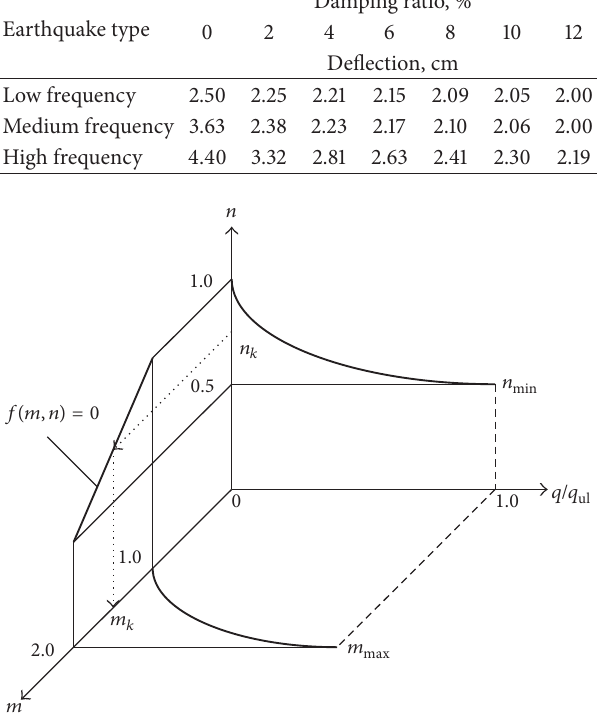
Figure 3: Relation between structural phenomenon and minimax principle: 𝑚 : generalized “increasing” parameter, 𝑛 : generalized “decreasing” parameter, 𝑓(𝑚,𝑛) : function, relating the parameters (conditionally shown by a straight line), and 𝑚 𝑘 , 𝑛 𝑘 : arbitrary values of the